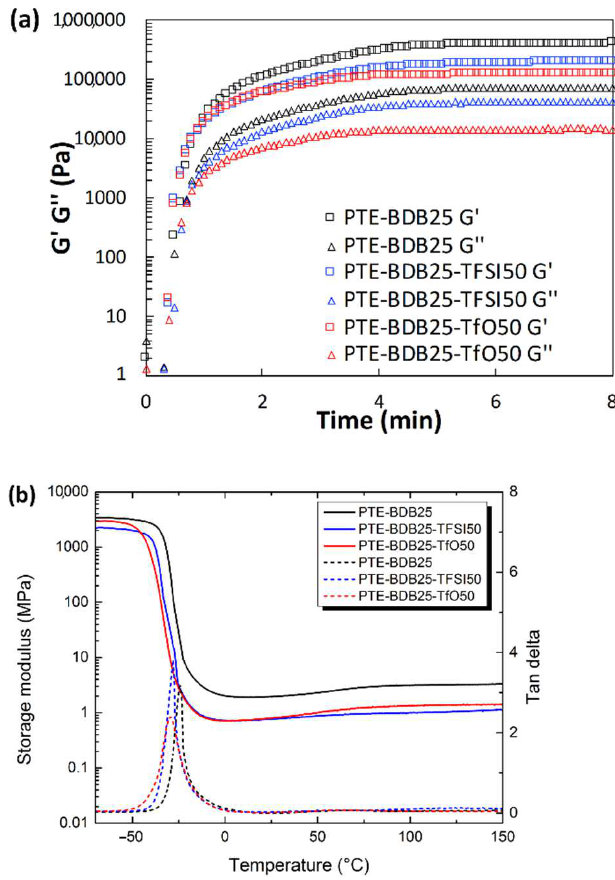
Figure 5. ( a ) Rheological studies of the PTE-BDB25-TFSI50 and PTE-BDB25-TfO50 precursor mixtures during in situ photopolymerization compared with PTE-BDB25 samples; ( b ) DMA tests of PTE-BDB-IL ionogels and PTE-BDB25 sample.